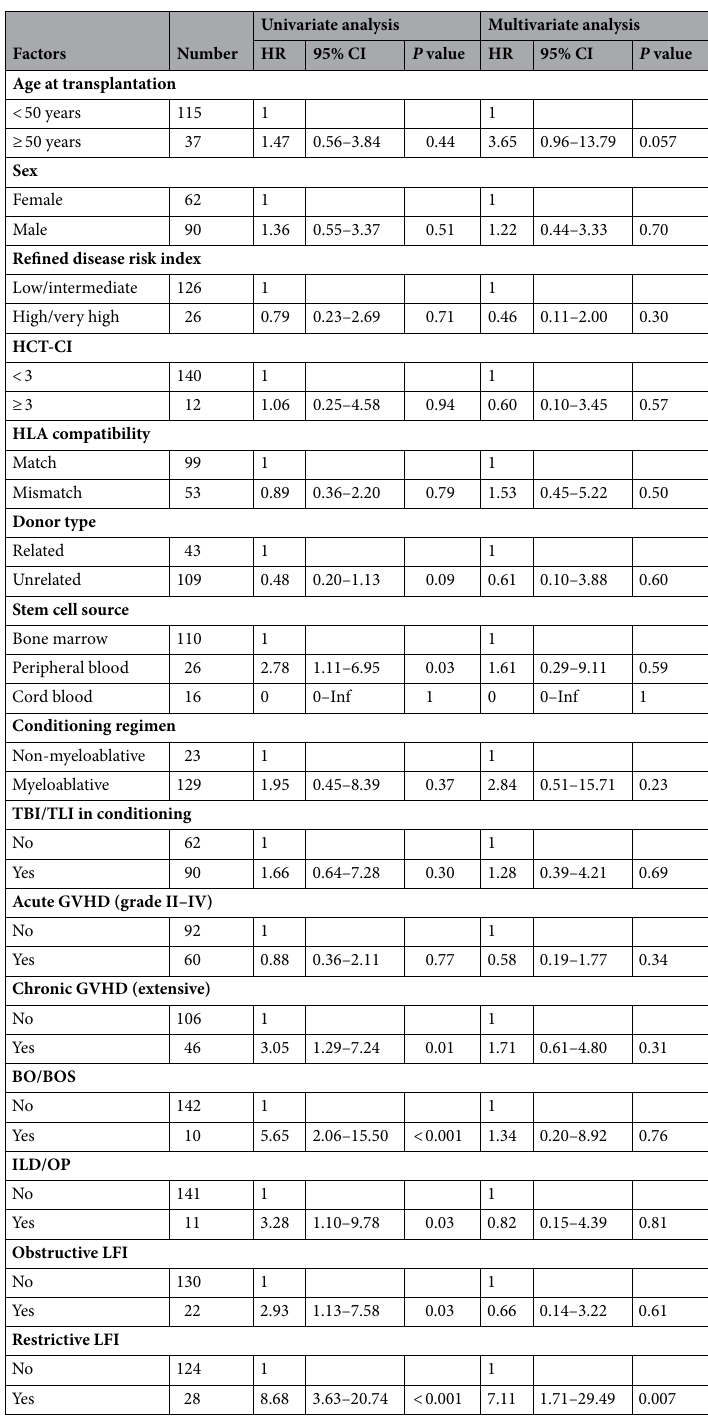
Table 3. Characteristics of the patients and factors associated with overall survival. HR hazard ratio, CI confidence interval, HCT-CI Hematopoietic Cell Transplantation Comorbidity Index, HLA human leukocyte antigen, Inf infinite, TBI total body irradiation, GVHD graft-versus-host disease, BO bronchiolitis obliterans, BOS bronchiolitis obliterans syndrome, ILD interstitial lung disease, OP organizing pneumonia, LFI lung function